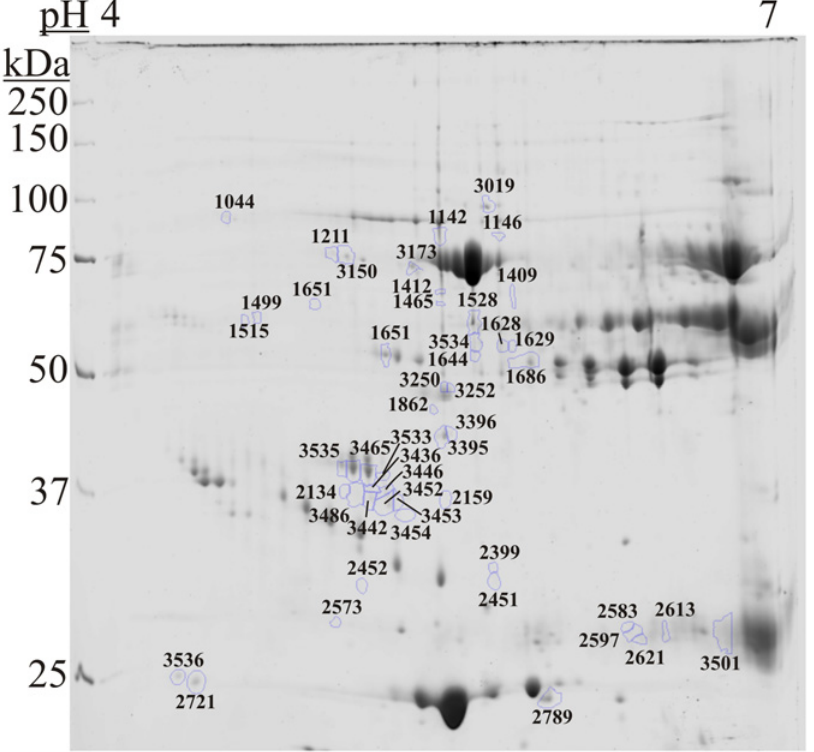
Fig 2. Two-dimensional gel electrophoresis. Depleted serum from 32 sea lions was separated using 2-dimensional gel electrophoresis. Shown is a representative gel with 49 spots of interest that were used for downstream